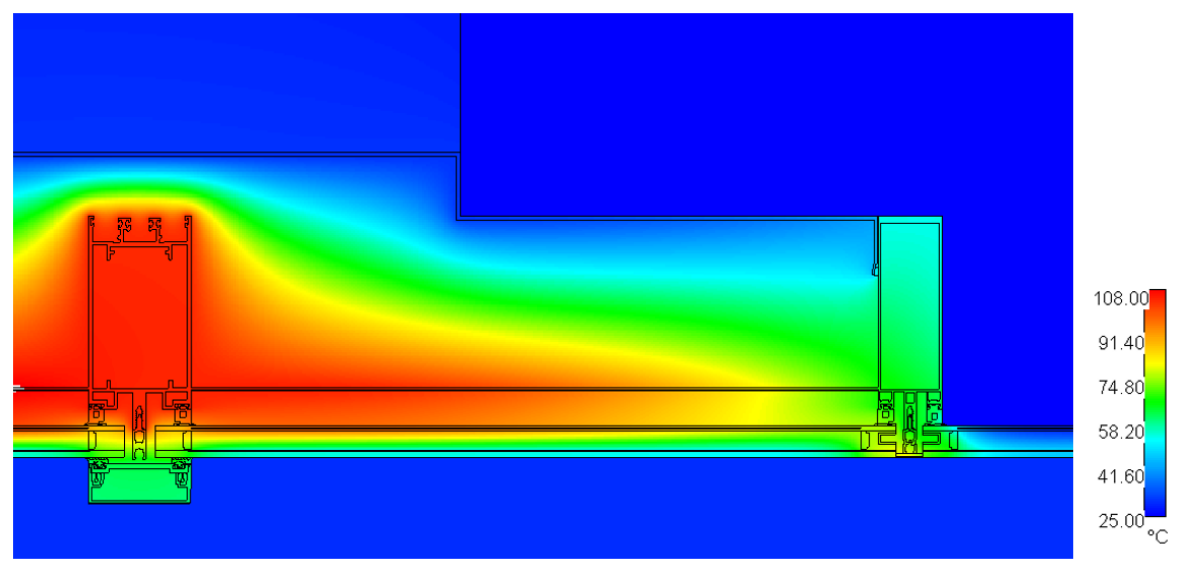
Fig. 9: MAX. TEMPERATURE IN SUMMER – 2D calculation